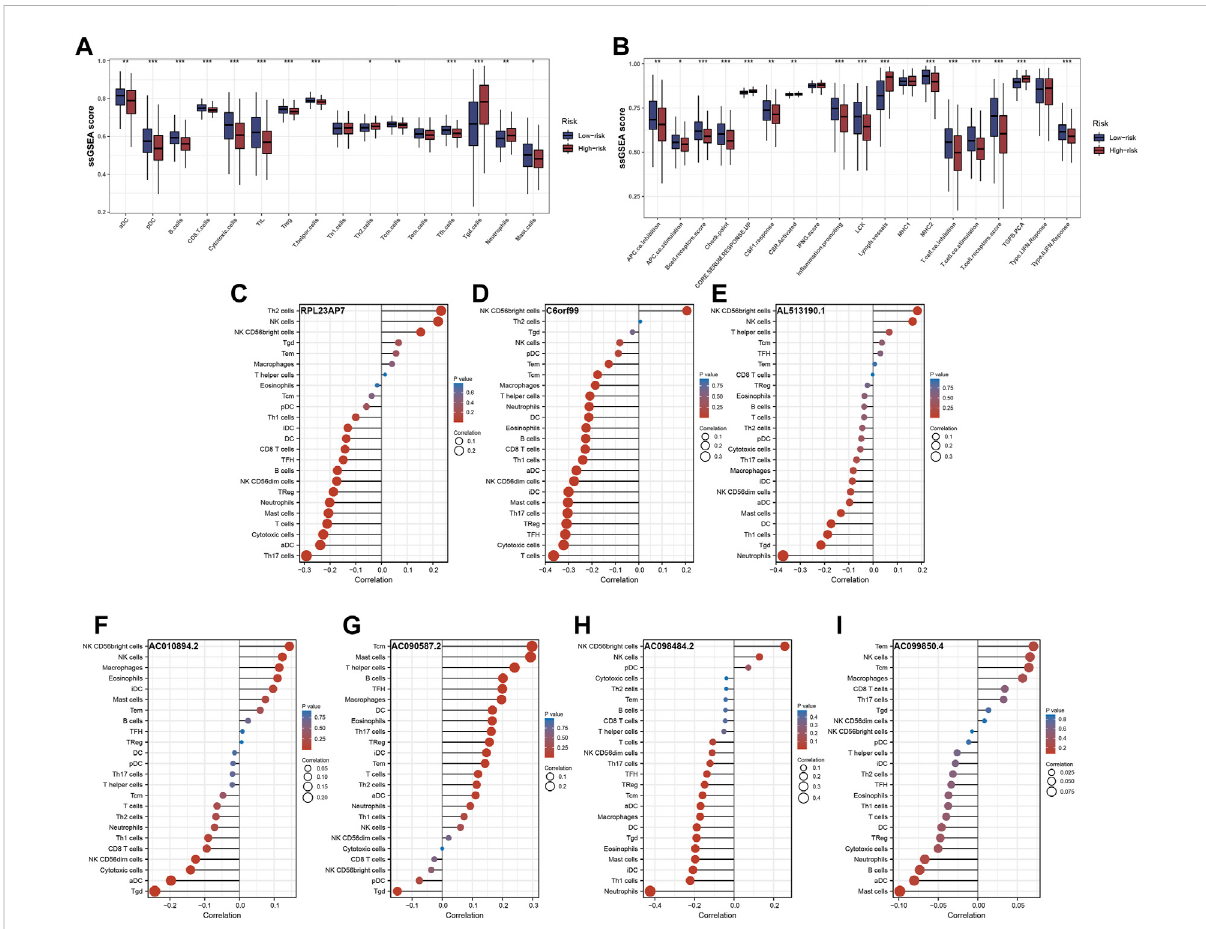
FIGURE 7 Immunein fi ltratingsignaturesofthesignature.Notes: (A , B) Differentialexpressionanalysisofimmunecellsandimmunefunctionsbetweenthe two groups. (C – I) Correlation analysis between the expression of each signature lncRNA and 22 immune